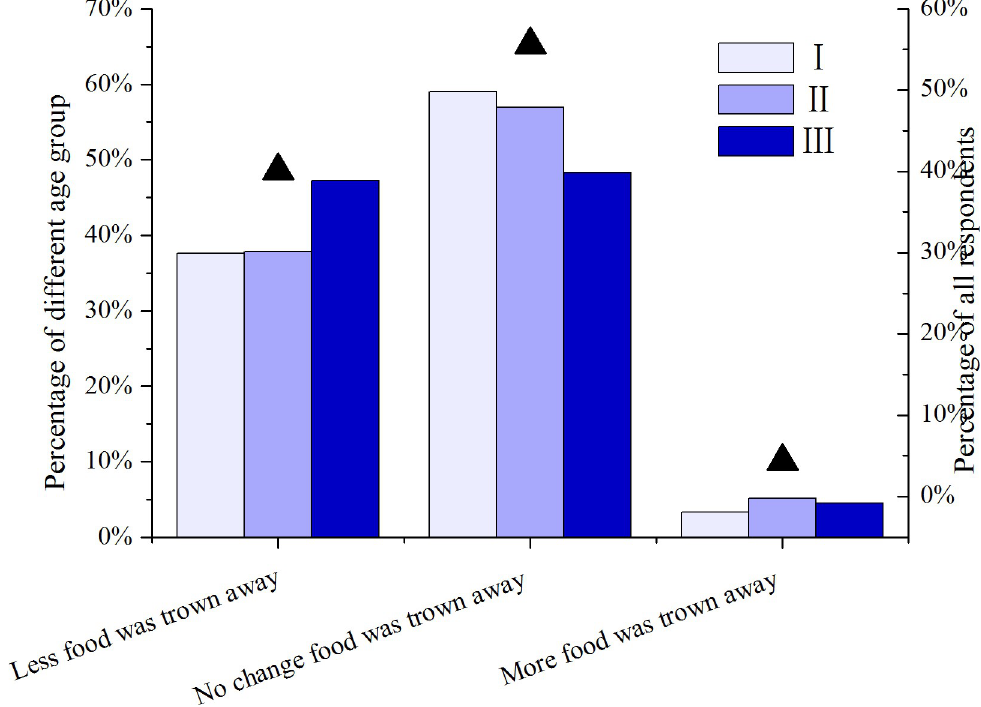
Fig 4. Wasted food amount change from all respondents (Solid triangle) and different age groups (bar) during the pandemic (p = 0.006).